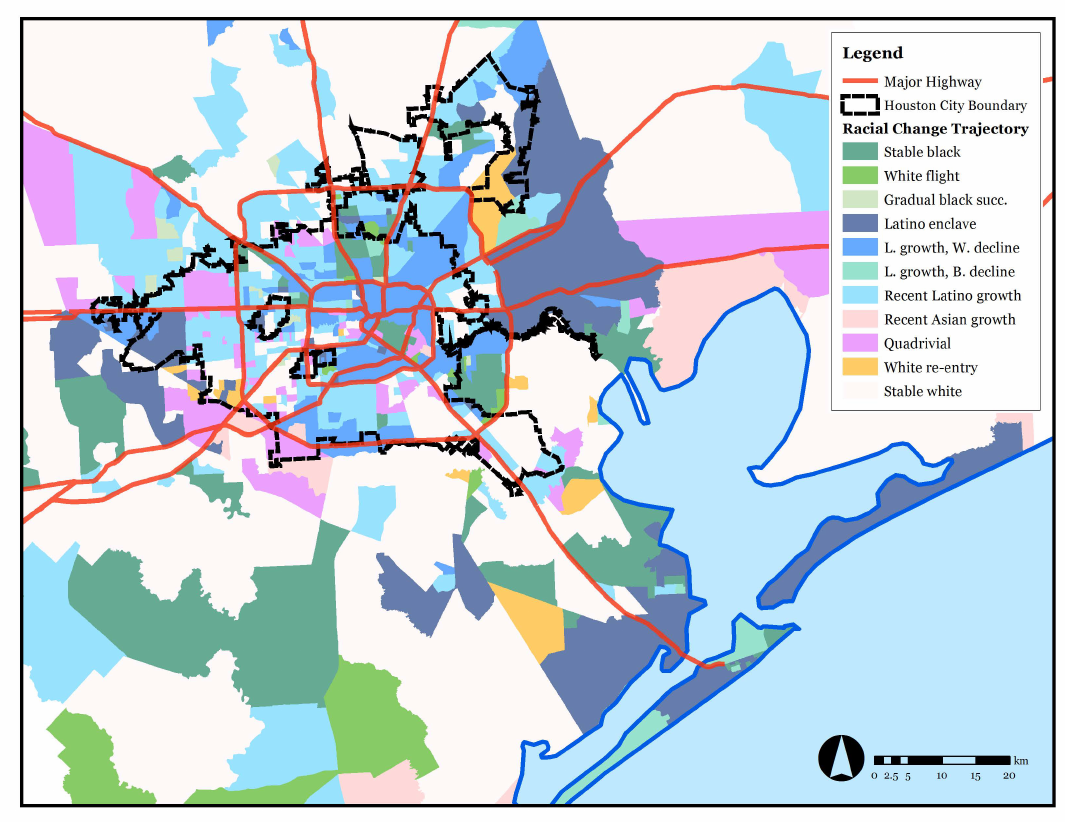
Figure 6: Map of neighborhood racial change trajectories from 1970–2010 in the Houston metropolitan area (map shows a detail of neighborhoods in and near Houston; a map of the complete CMSA is available upon